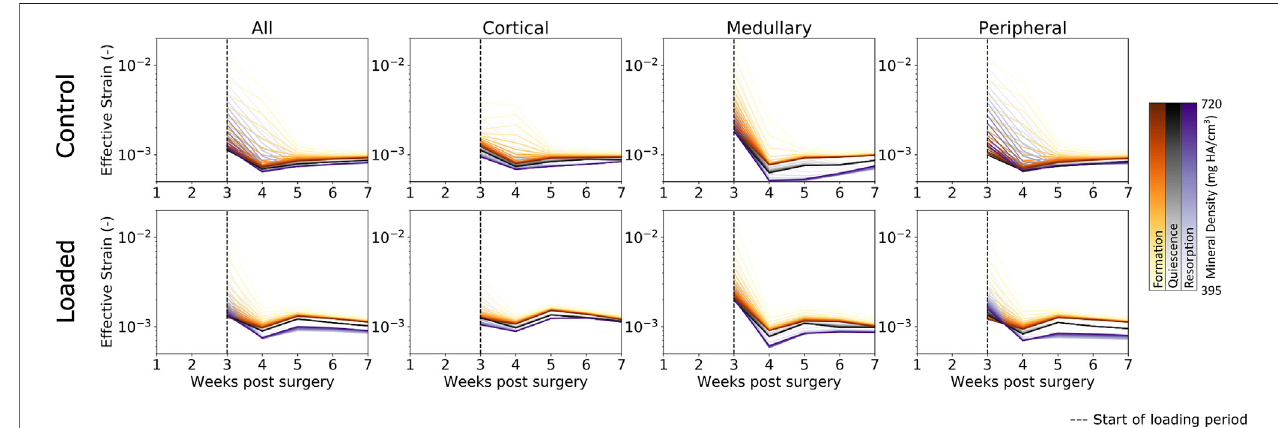
FIGURE 4 | Longitudinal mechanical environment in femur defect regions. As lowly mineralized tissue further mineralized, the mechanical environment becomes more homogenous between bone of differing densities in both the control and loaded groups. For all densities of formation, the average effective strain was higher than for quiescent or resorption voxels, while resorption voxels displayed the lowest effective strain on average of the three possible